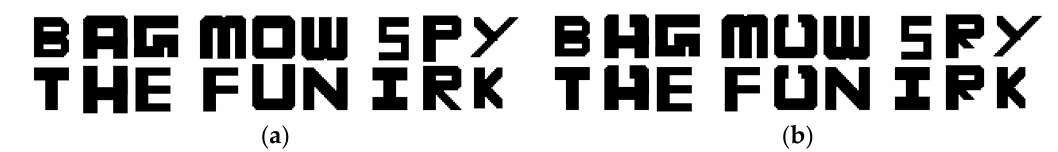
Figure 9. The training and test sets for the CINET(2) classifier ( a ) the noise-free context-augmented training set ( b ) the test set with noise-free congruent context.